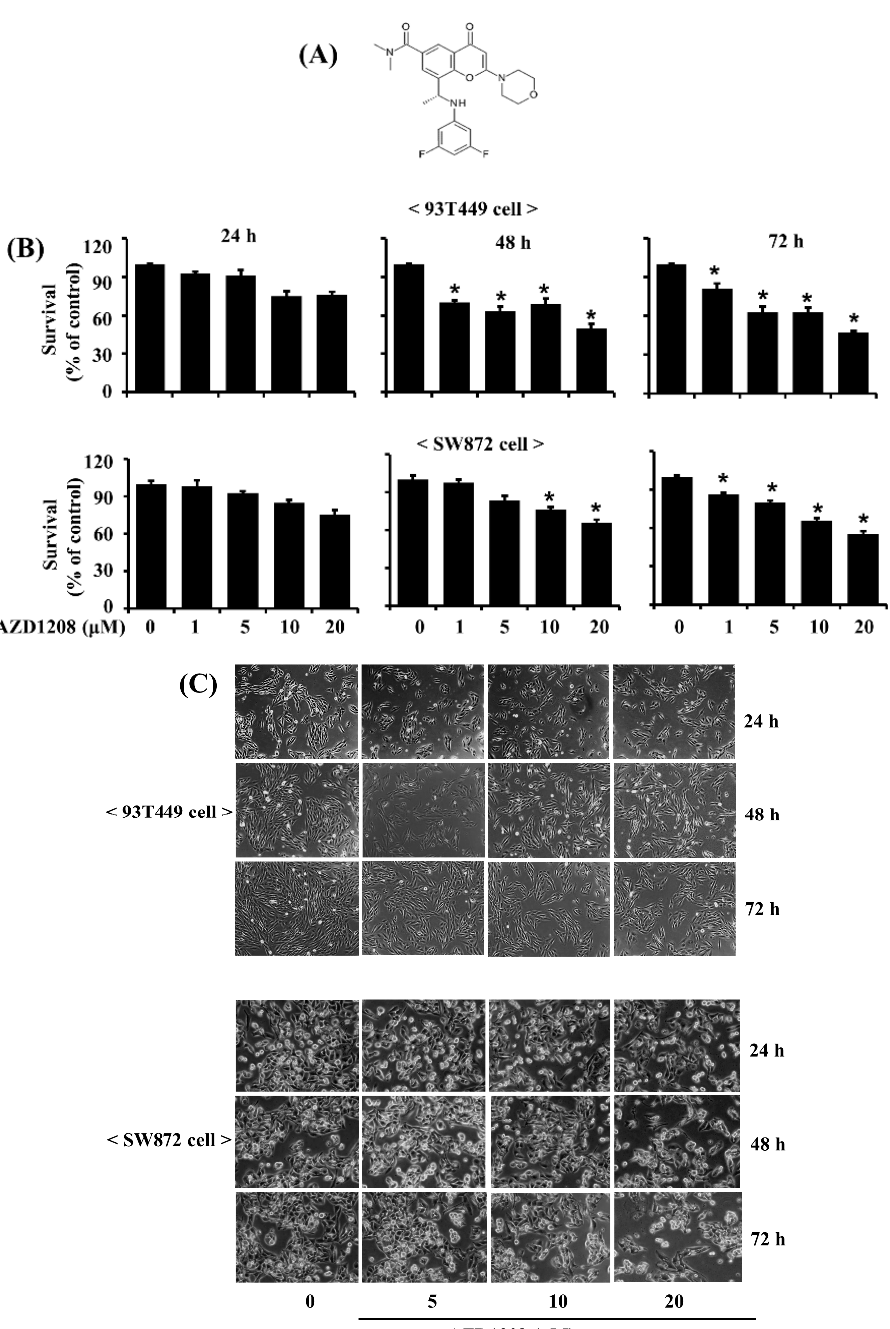
Figure 1. Effect of AZD1208 on survival of 93T449 and SW872 cells. ( A ) The chemical structure of AZD1208. ( B ) 93T449 and SW872 cells were treated with AZD1208 or vehicle control (DMSO; 0.1%) at the indicated concentrations and for the indicated times. The numbers of surviving cells were measured by cell count assay. The cell count assay was performed in triplicate. Data are means ± SE of three independent experiments. * p < 0.05 compared to the value of AZD1208 free control at the indicated time. ( C ) 93T449 and SW872 cells were treated with AZD1208 or vehicle control (DMSO) for the indicated times. Images of the conditioned cells were obtained by phase contrast microscopy, 200 × . Each image is a representative of three independent experiments.